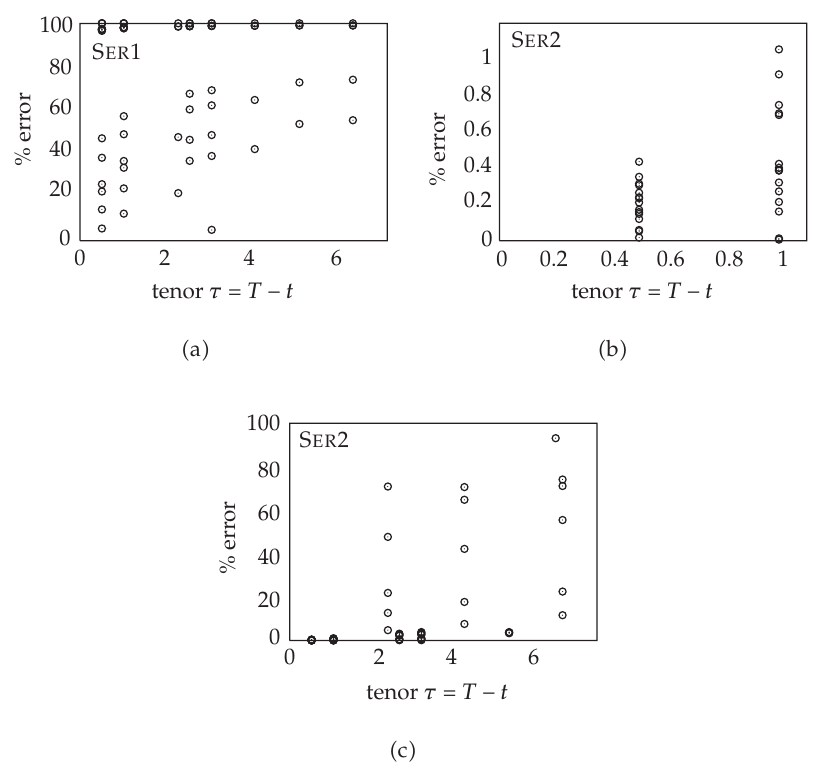
Figure 2.2 . Percentage error in the value of a put option using series ( 1.4 ) for a number of sample runs. ( a ) constant term only; ( b ) and ( c ) both terms in